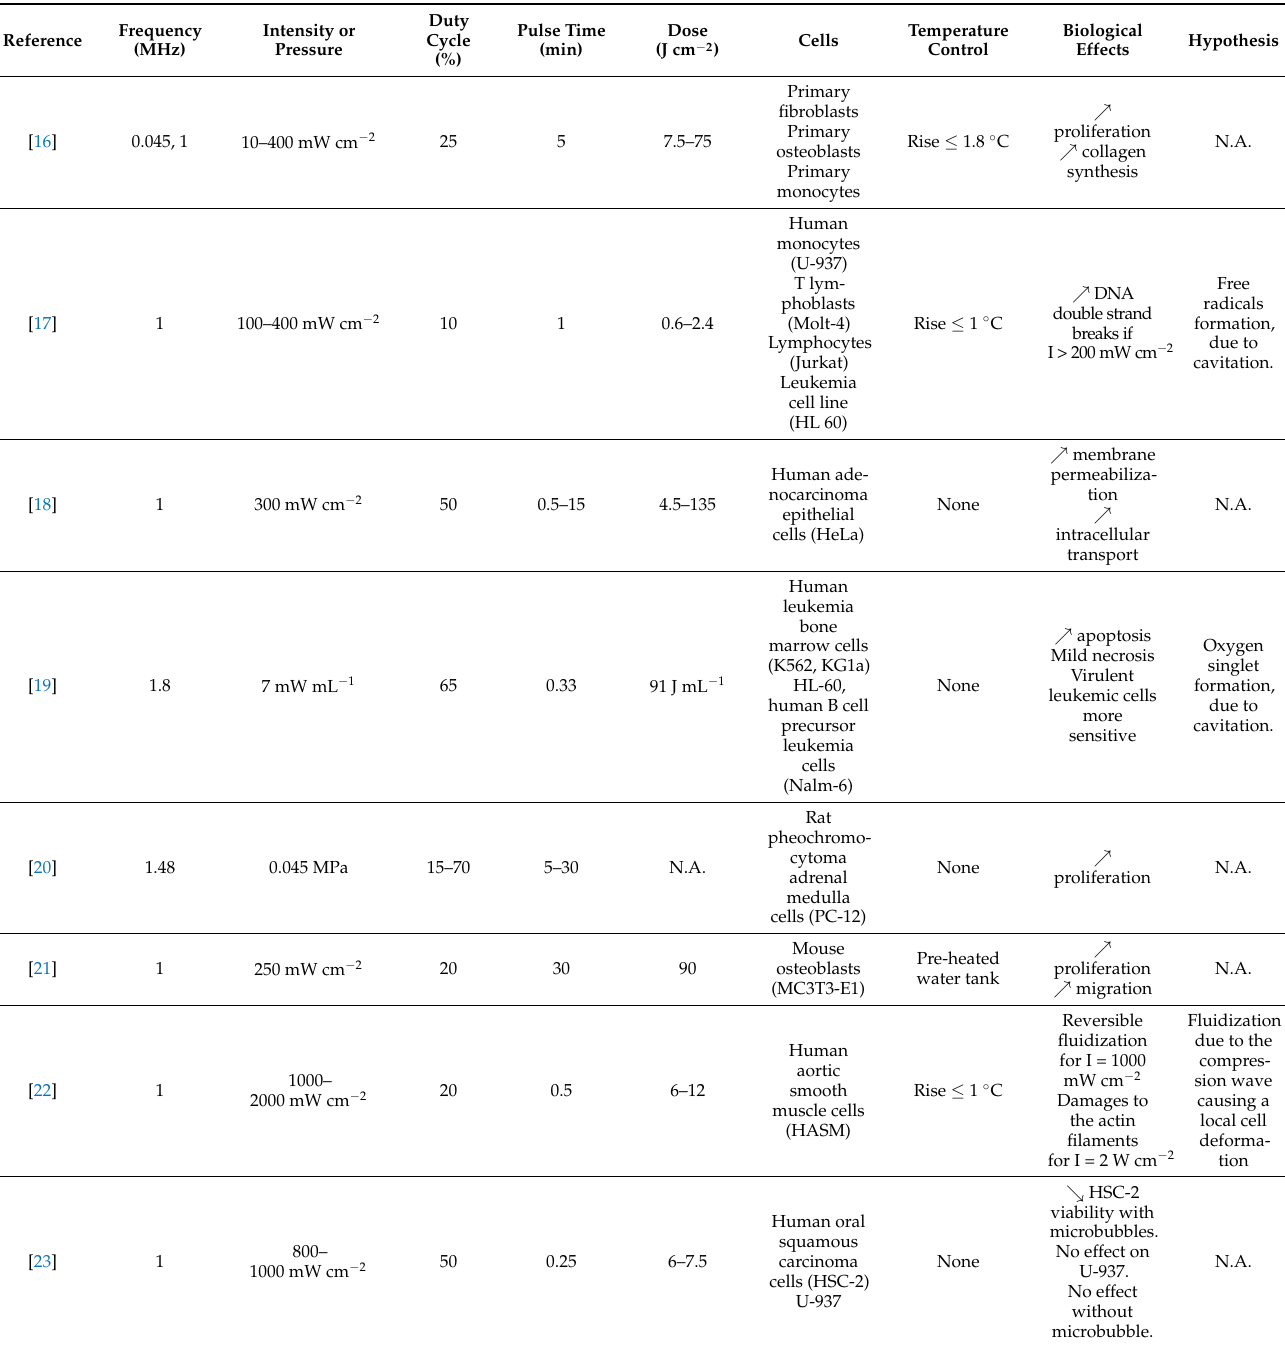
Table 1. Summary table of the impacts on mammal cells of US at frequencies under 10 MHz. ( (cid:37) : increase in, (cid:38) : decrease in, N.A.: not